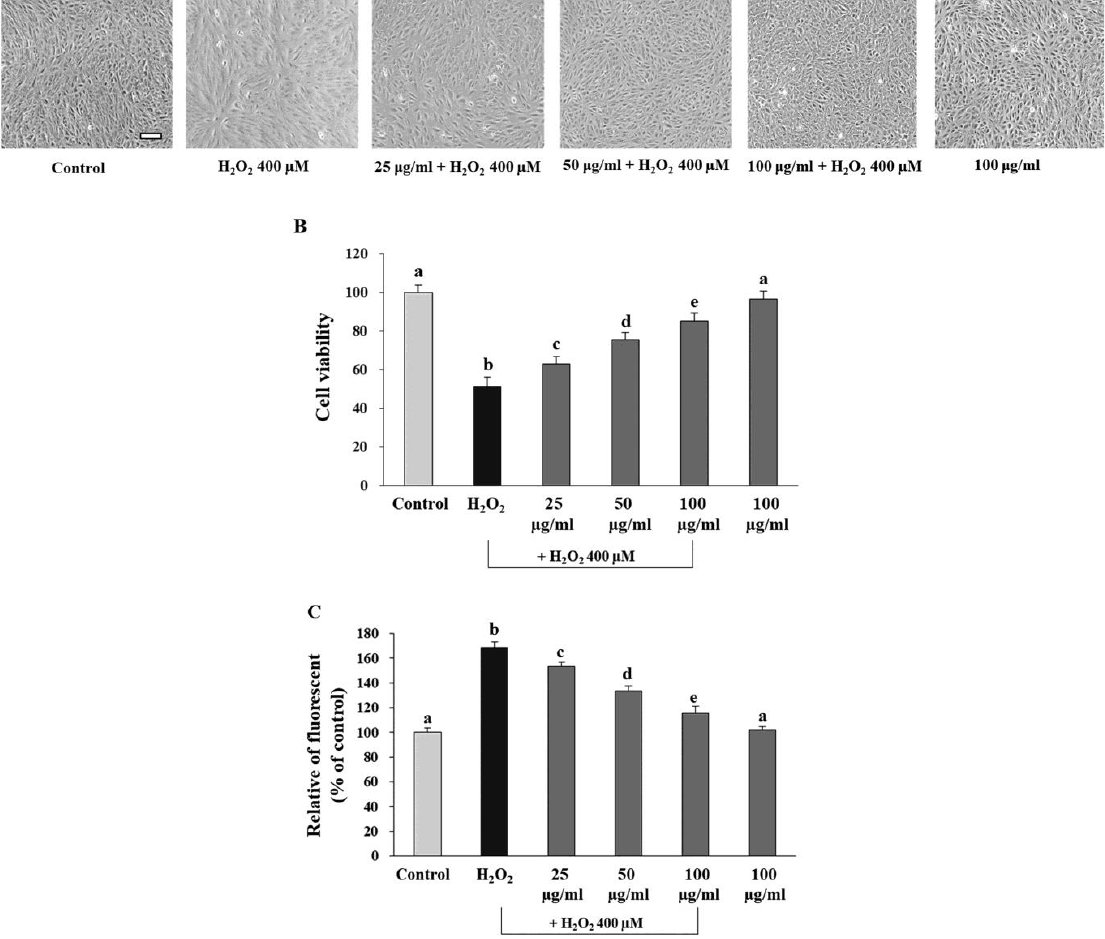
Figure 6. Evaluation of the effect of compound 3 on cell viability and ROS production in oxidative- stress-induced ARPE-19 cells. Cells were pre-treated with compound 3 at 25, 50 and 100 µg/mL for 24 h, followed by incubation with H 2 O 2 at 400 µM for 60 min. ( A ) Cell morphology under all experimental conditions was observed by phase-contrast microscopy. Scale bar represents 100 µm; ( B ) viability of cells was determined using an MTT assay; ( C ) production of ROS was measured by a DCFH-DA assay. Results present average cell viability and ROS production as mean ± SD ( n = 4). Different superscript letters (a – e) indicate significant differences between values in the column ( p < 0.05).